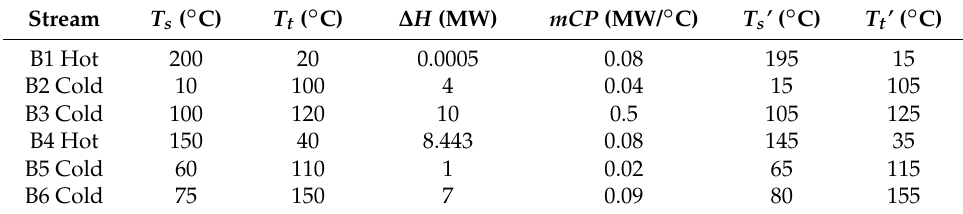
Table 2. Stream data for Industrial Plant B with ∆ T min, pp 10 ◦ C [19].